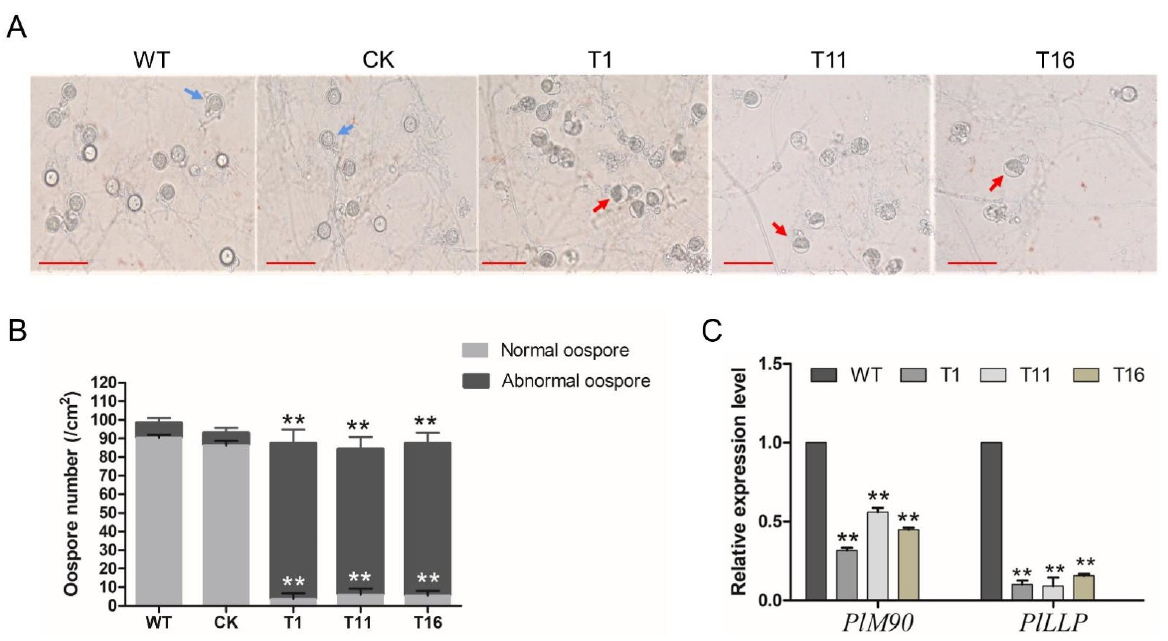
Figure 6. Deletion of PlCZF1 produced many aborted oospores. ( A ) Morphology of oospores produced in 17 days old cultures of WT, CK and ∆ plczf1 mutants. Blue arrows indicate the normal oospore and red arrows indicate the abnormal oospore. The bars indicate 20 μ m. ( B ) Amount of normal and aborted oospores produced by WT strain, control strain and the aborted mutants. Data represent means ± SD from three independent biological repeats, and asterisks indicate significant differences (** p < 0.01 compared with WT, Dunnett’s test). ( C ) The relative expression level of PlM90 , PlLLP in ∆ plczf1 mutants. The constitutive expression of PlActin was used as reference gene. Data represent means ± SD from three independent biological repeats, and asterisks denote significant differences from the control group (Student’s t test: ** p < 0.01).